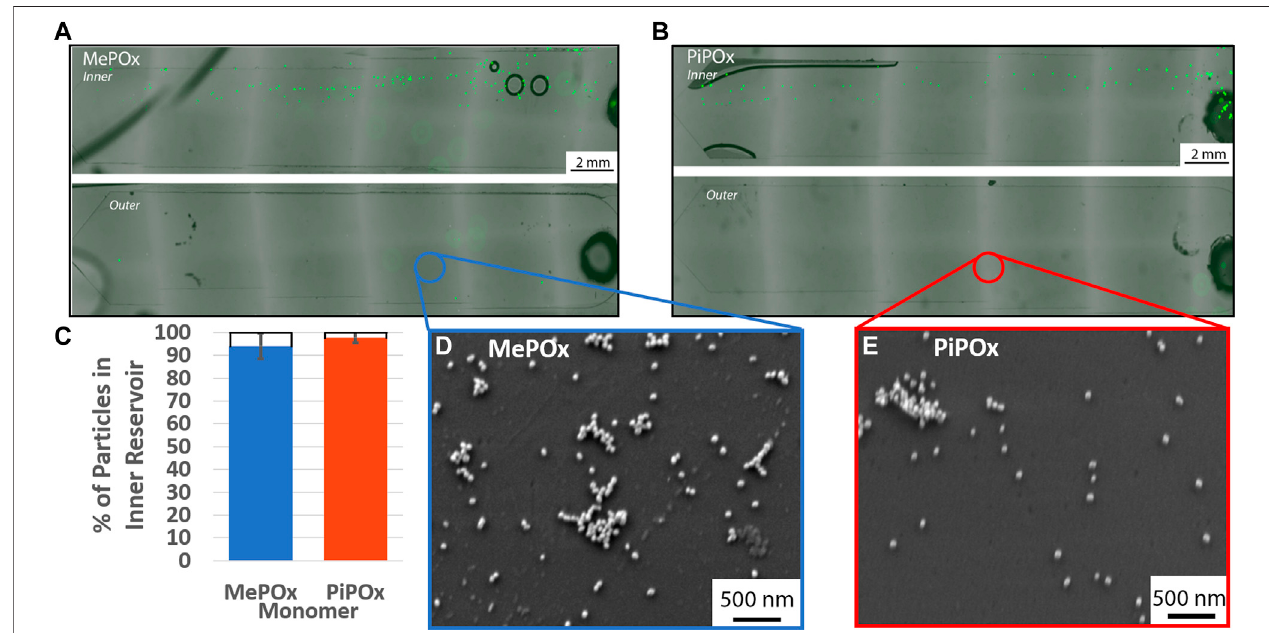
FIGURE 5 | Representative fl uorescent images of inner (top) and outer (bottom) reservoirs functionalised with MePOx (A) and PiPOx (B) containing separated 20 µm particles from a 1:9 mixture of fl uorescent particles and 68 nm AuNPs. (C) Separation ef fi ciency of 20 µm particles in a 1:9 mixture of fl uorescent particles and 68 nmAuNPs.SEMimagesofthereservoirsurfaceshowingAuNPcapturedonMePOx (D) andPiPOx (E) fromtheparticlemixture.Separationconditionsused:12loop spiral, 300 μ